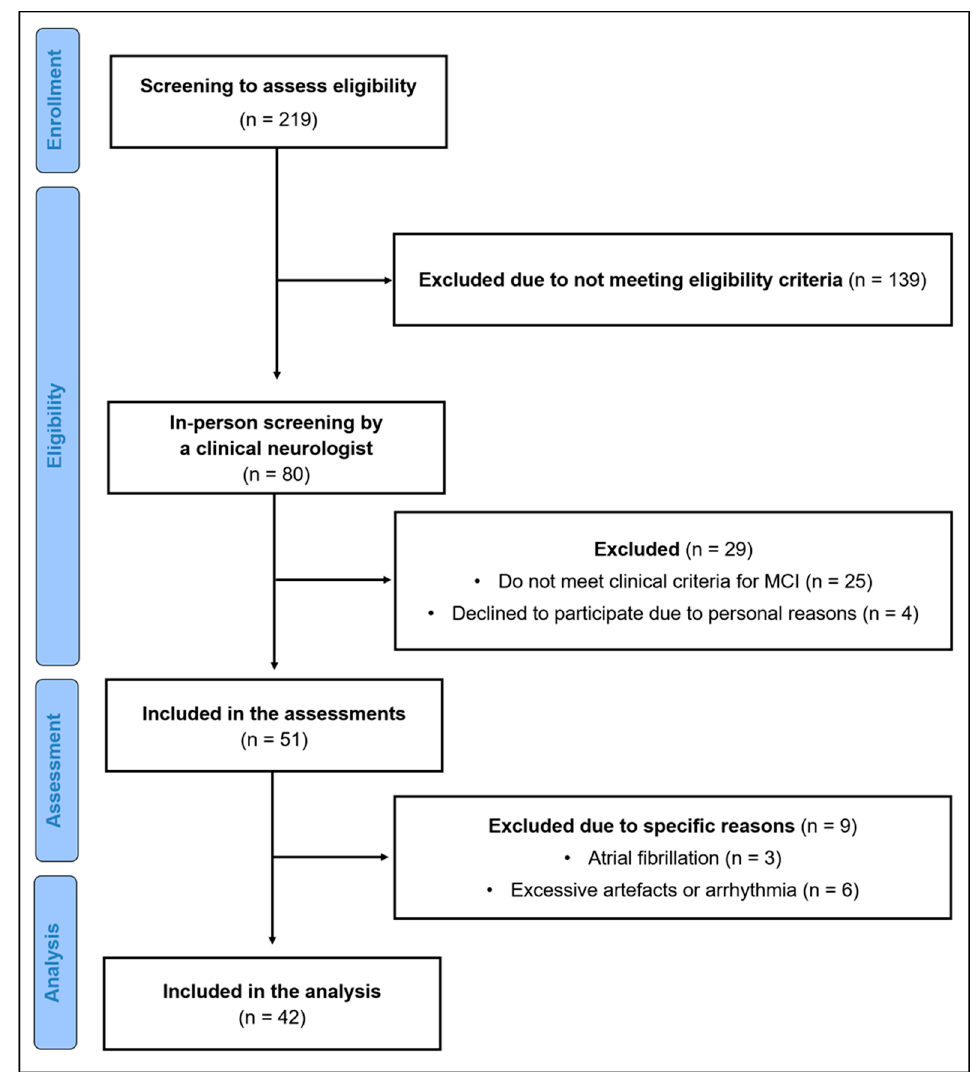
Figure 1. Flow diagram of participants.